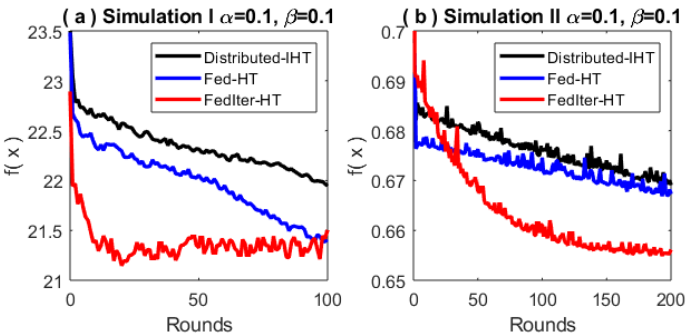
Figure 3. The comparison of different algorithms in terms of the objective function value vs. commu- nication rounds ( a , b ) and for regression ( a ) and classification ( b ). Note that the Distributed-IHT is the baseline method that communicates every local update (so the number of rounds equals the number of iterations) and may be the best scenario for reducing the objective value.